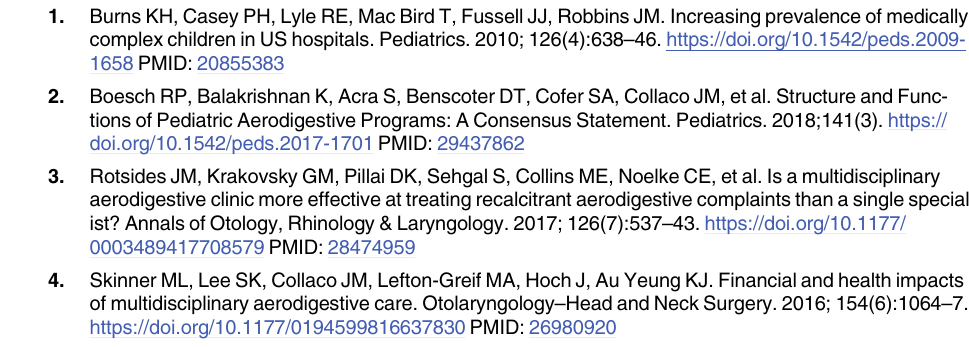
S1 Table. The form of interview for subjective symptoms